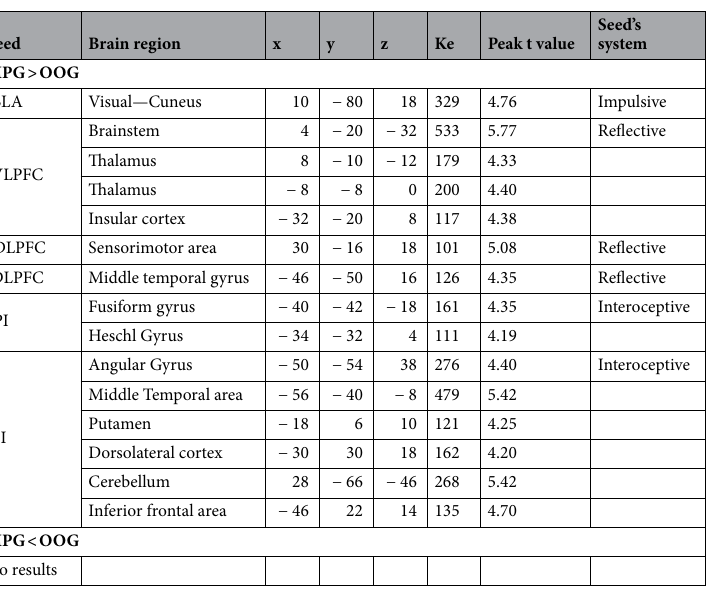
Table 3. Significant differences between MPG and OOG in seed-based functional connectivity. Coordinates (x, y, z) are given in Montreal Neurological Institute atlas space (MNI). Ke cluster size in voxels; All the results have exceeded the minimum threshold p < 0.001 and number of voxels for each seed. Seed’s system system to which each seed corresponds according to the Triadic reflective–impulsive–interoceptive awareness model, MPG male perpetrators group, OOG other offenders group, lBLA left basolateral amygdala, lVLPFC left ventrolateral prefrontal cortex, rDLPFC right dorsolateral prefrontal cortex, lDLPFC left dorsolateral prefrontal cortex, rPI right posterior insula, lPI left posterior